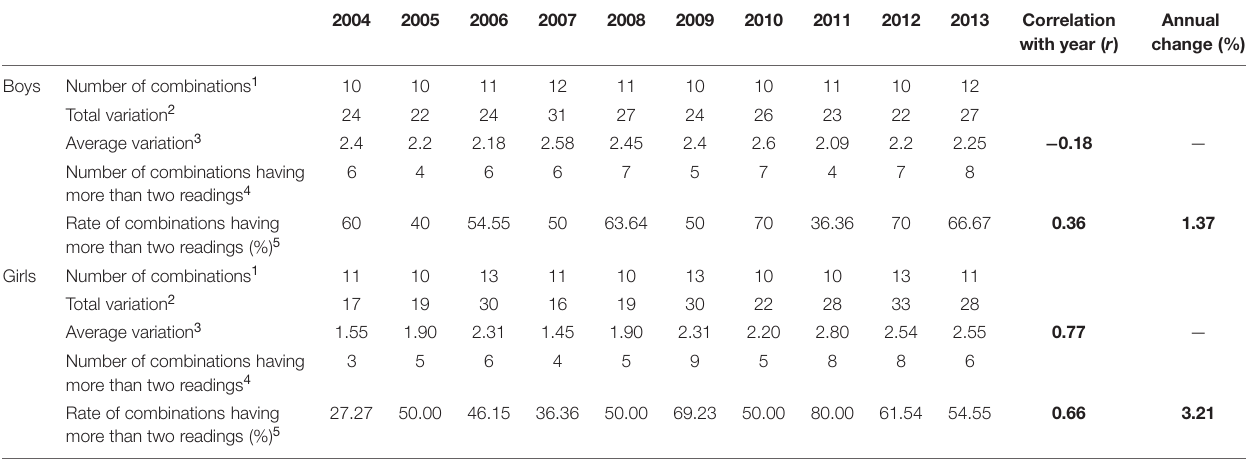
TABLE 6 | Variations of pronunciation in the top 10 most common combinations of Chinese characters (Study 2).